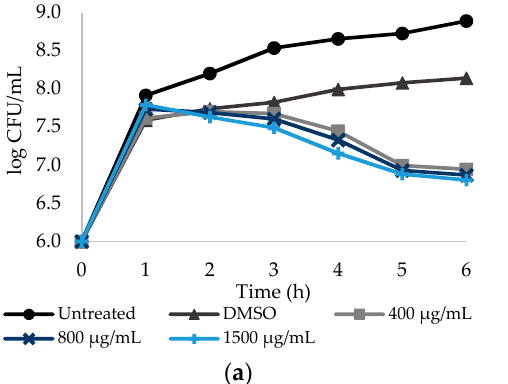
(Table S1—see Supplementary Data)—when compared to the control with DMSO. PXC at 400 and 800 μ g/mL caused 1.20 and 1.27 log CFU/mL reductions, respectively. Figure 1a also shows that the